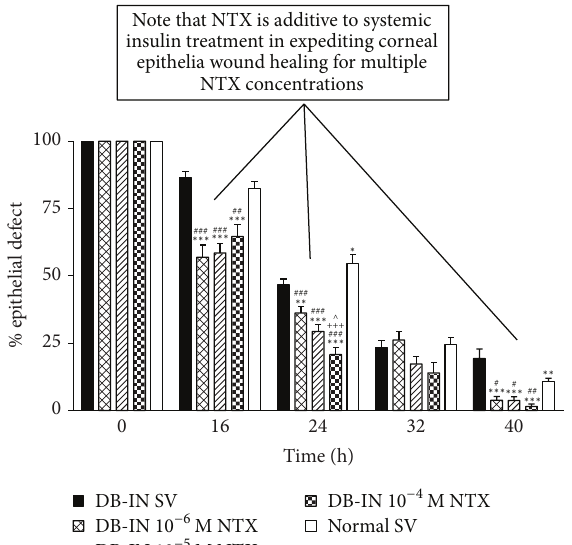
Figure 12: The figure compares the effectiveness of systemically administered insulin and topical NTX. Histograms demonstrate that topical NTX is additive to systemic insulin in facilitating epithelial wound healing in diabetic rats. Residual epithelial defects are presented as percentage of the original wound. Data expressed as means ± SEM. Significantly different from DB-IN rats receiving SV at ∗∗ 𝑃 < 0.01 or ∗∗∗ 𝑃 < 0.001 and from normal SV rats at # 𝑃 < 0.05 , ## 𝑃 < 0.01 , or ### 𝑃 < 0.001 . At 24 hrs, the 10 −4 M NTX DB-IN group differed from the 10 −5 M NTX DB-IN group at ∧ 𝑃 < 0.05 and from the 10 −6 M NTX DB-IN group at +++ 𝑃 < 0.001 (derived from [44]).